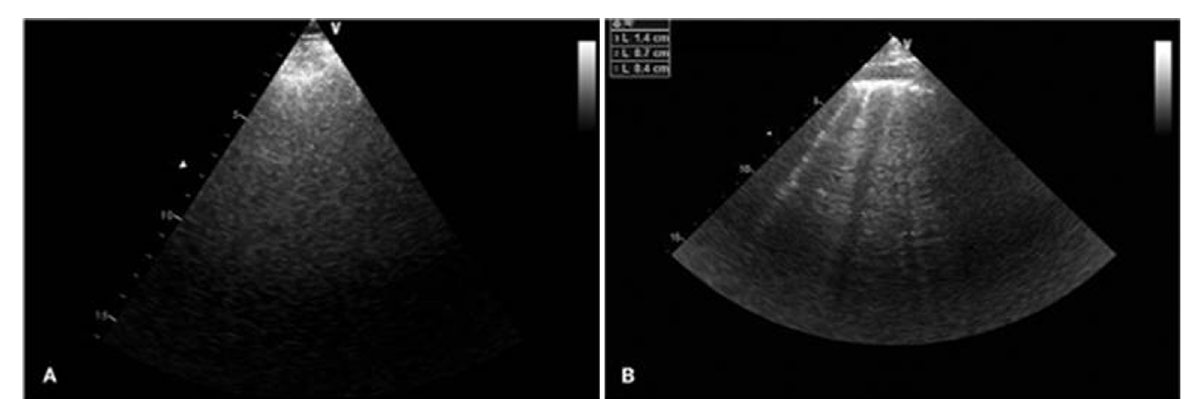
Age from 20 to 75 years old. Sex: male and females. From Fayoum